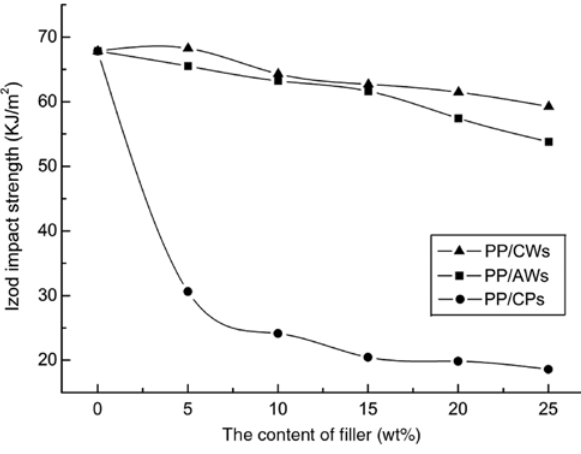
Figure 4: The results of notched impact strength for PP/CWs, PP/AWs, and PP/CPs composites.